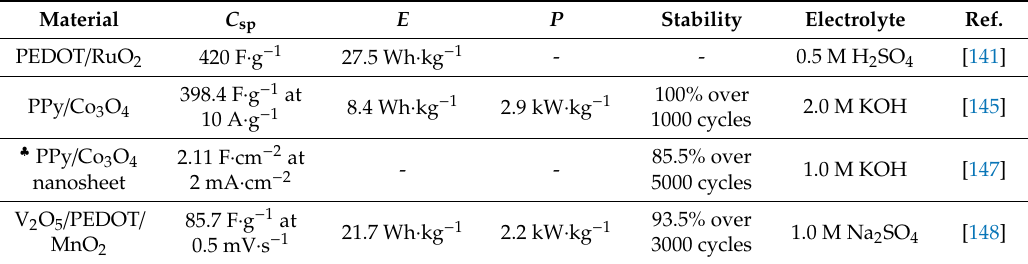
Figure 19. Scheme and digital images showing the fabrication of ( a ) layered vanadium oxide (LVO) aerogel, ( b ) layered vanadium oxide / poly(3,4-ethylenedioxythiophene) LVO / PEDOT, and ( c ) layered vanadium oxide / poly(3,4-ethylenedioxythiophene) / layered manganese oxide LVO / PEDOT / LMO [148]. Table 3. Conducting polymer-metal oxides-based layer-by-layer